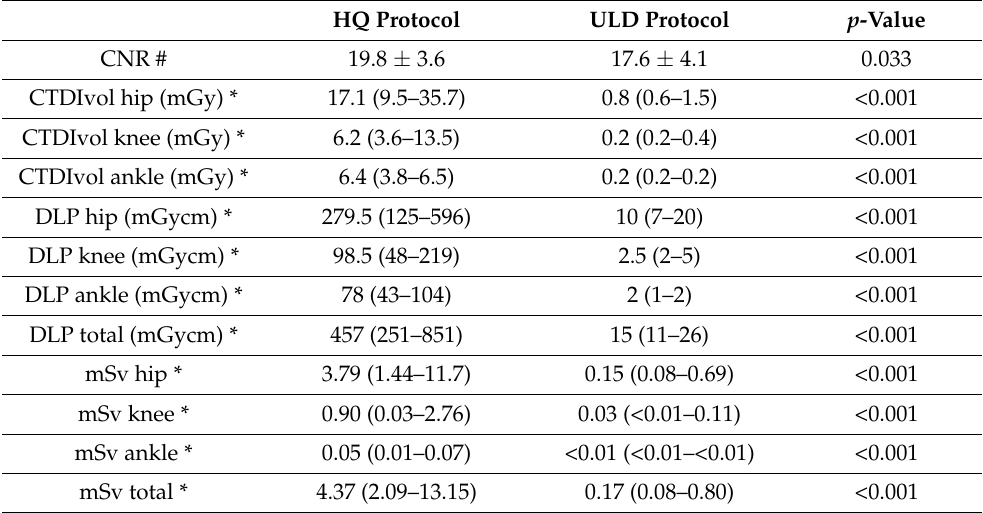
Figure 4. Example images of the newly introduced ULD protocol in three different patients with a BMI between 18.9 kg/m 2 and 38.0 kg/m 2 ( A ) female, 28 years, BMI = 18.9 kg/m 2 , CNR = 19.5, total dose equivalent = 0.27 mSv; ( B ) female, 17 years, BMI = 25.2 kg/m 2 , CNR = 16.5, total dose equivalent = 0.19 mSv; ( C ) female, 46 years, BMI 38.0 kg/m 2 , CNR = 15.9, total dose equivalent = 0.60 mSv). Table 2. Correlation of the measured body contour parameters in CT at the femoral head level with the body mass in- Table 3. Parameters of the radiation dosage and CNR in the HQ protocol and in the new ULD dex. protocol for CT-torsion